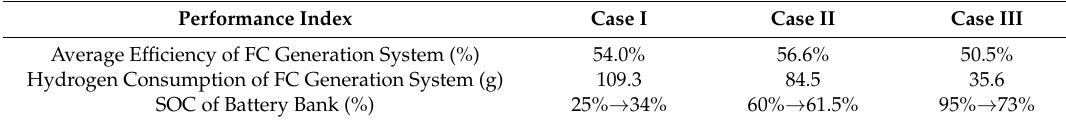
Table 4. The control performance of DC microgrid in each